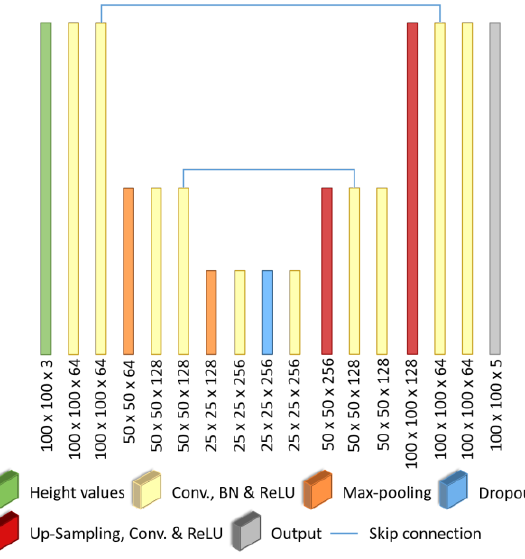
Figure 2. Network structure of the proposed approach